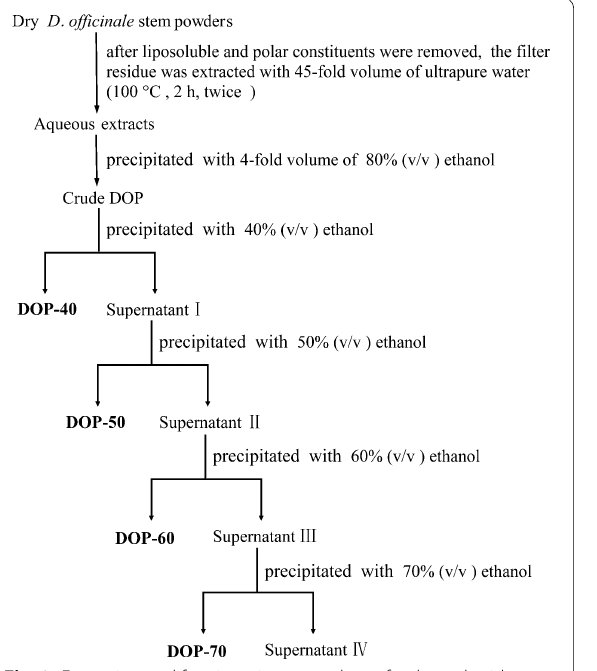
Fig. 2 Extraction and fractionation procedure of polysaccharide fractions from Dendrobium officinale